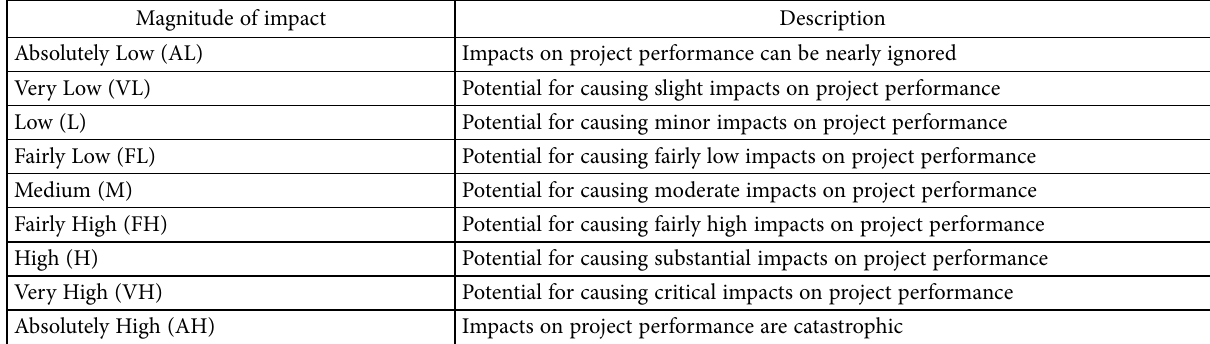
Table B2. The nine-point linguistic scale for assessing magnitudes of impact of each risk